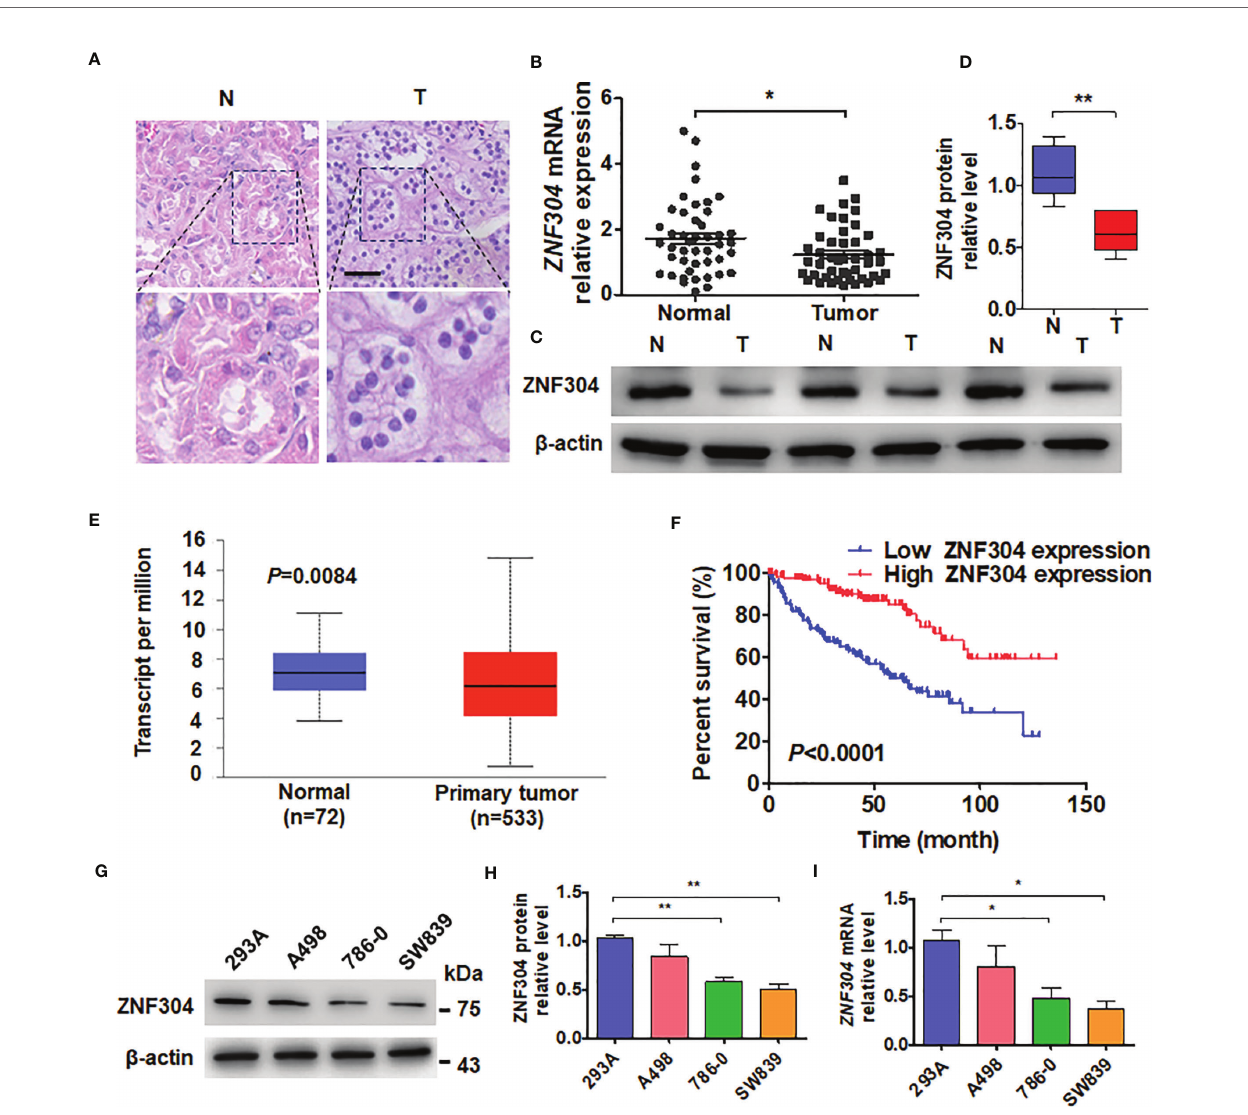
FIGURE 1 | ZNF304 downregulation in ccRCC is correlated with good prognosis. (A) Staining of Hematoxylin and eosin in ccRCC (T) and normal (N) kidney tissues. Scale Bar = 50 m m. (B) RT-qPCR was use to examine ZNF304 mRNA level in ccRCC (T, n = 43) and normal kidney (N, n = 43) tissues. (C) Western blot analysis detected the protein levels of ZNF304 in ccRCC (T) and normal (N) kidney tissues (D) Quantitative analysis of (C) . (E) ZNF304 mRNA levels were analyzed from data of the TCGA database. (F) Kaplan – Meier analysis of the overall survival of ccRCC patients in the TCGA database with low (n = 130) and high (n = 130) ZNF304 levels (cutoff value is 25%). (G) Western blot was used to measure the proteins level of ZNF304 in 293A and RCC cell lines (A498, 786-0, and SW839). (H) Quantitative analysis of (G) . (I) qRT-PCR was performed to detect the ZNF304 mRNA level in the above cell lines. All data are from three independent experiments and expressed as the mean ± SEM. *P < 0.05, **P < 0.01 vs. the corresponding